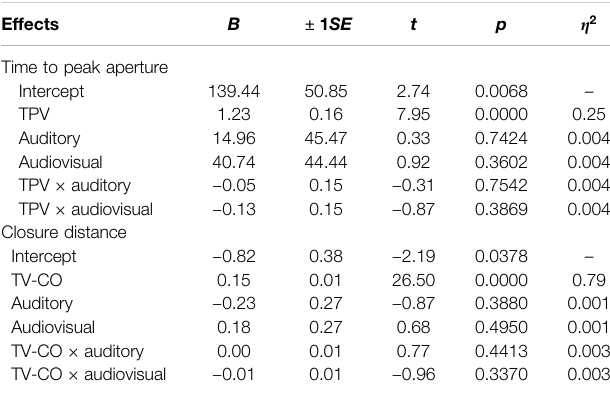
TABLE 2 | Summary of linear mixed-effects (LME) models in Study 1.